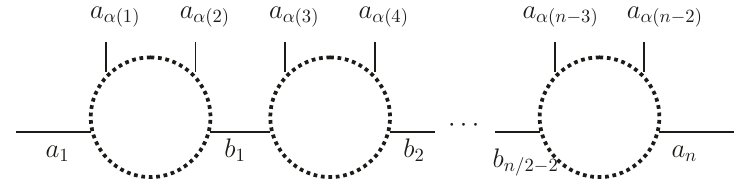
Figure 8 . The half-ladder after applying the completeness relation. Each dotted circle contains either a “ × ” or an “ =